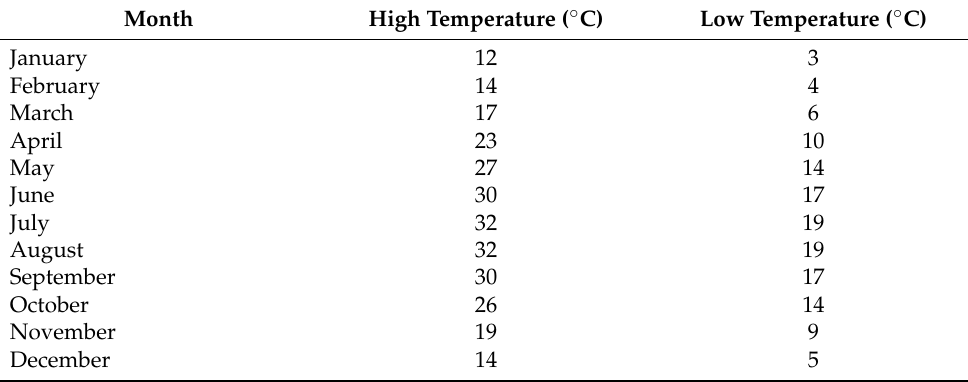
Table 1. Temperature data in Amman, 2021